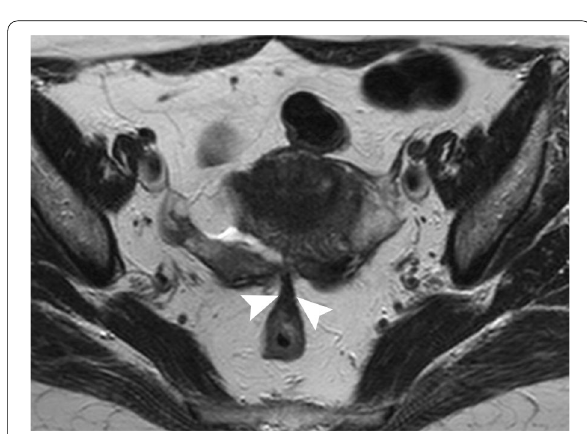
Fig. 13 DIE of the pouch of Douglas. TSE T2w axial image. Teardrop deformation of the rectum for DIE adhesions (arrowheads) is seen